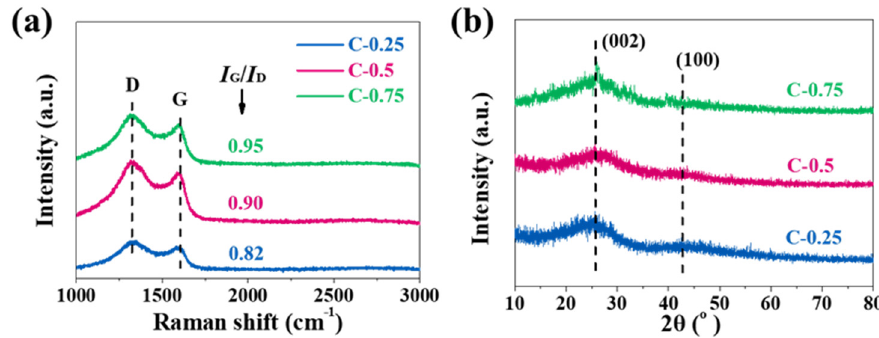
Figure 2. ( a ) Raman and ( b ) the X-ray diffraction (XRD) patterns of all porous carbons.